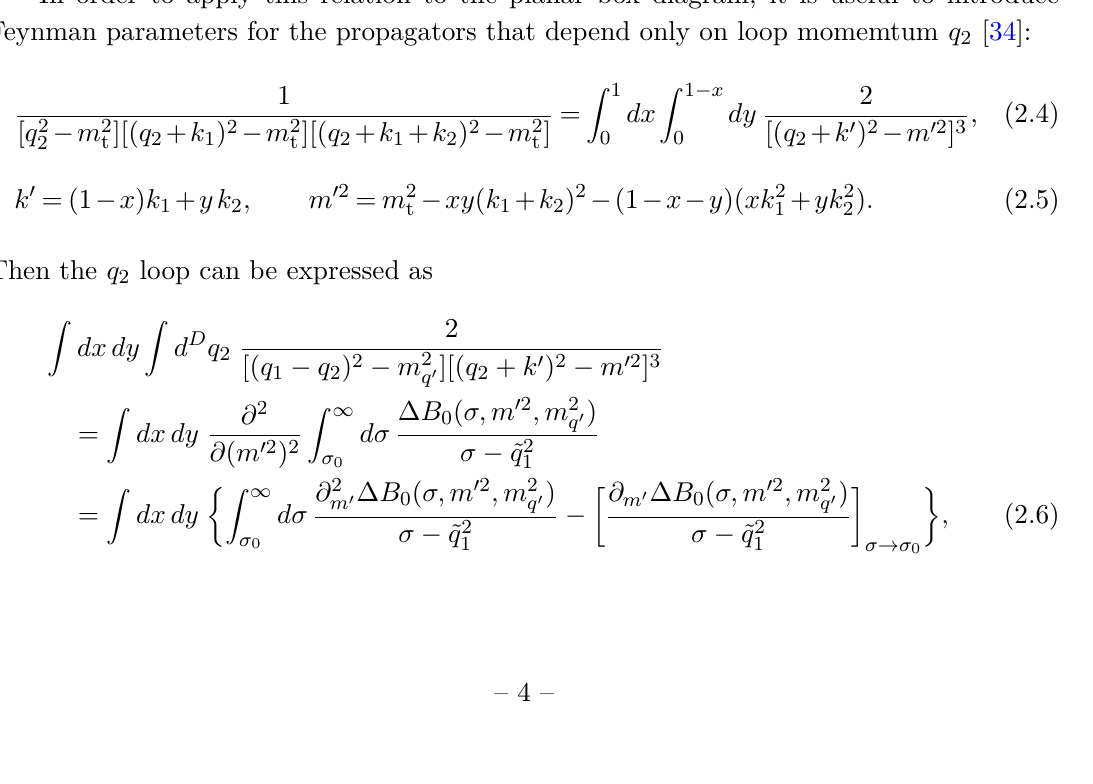
Figure 2. Integration contours for the dispersion relations for the one-loop scalar self-energy function B 0 for the cases m 2 the branch cuts, ending at the branch point ( m 1 + m 2 ) 2 . The circle sections are understood to have a radius R → ∞